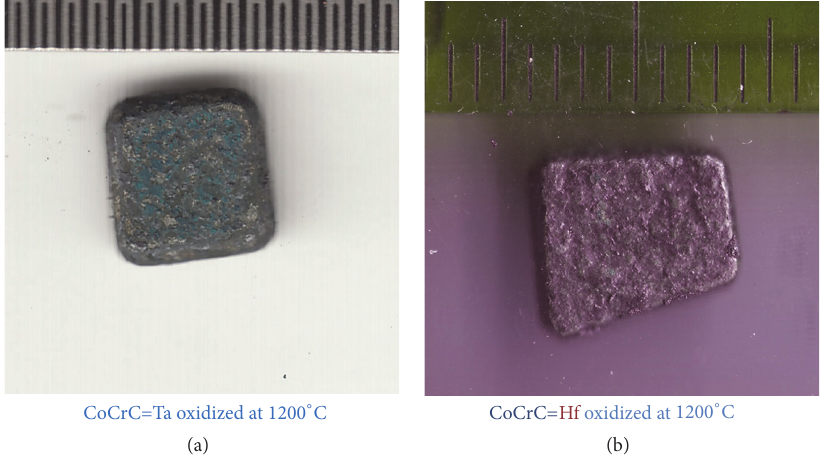
Figure 10: Surface states of the “CoCrC=Ta” alloy oxidized in air at 1200 ∘ C and cooled at − 5 ∘ Cmin −1 (a) and of the “CoCrC=Hf” alloy oxidized and cooled in the same conditions